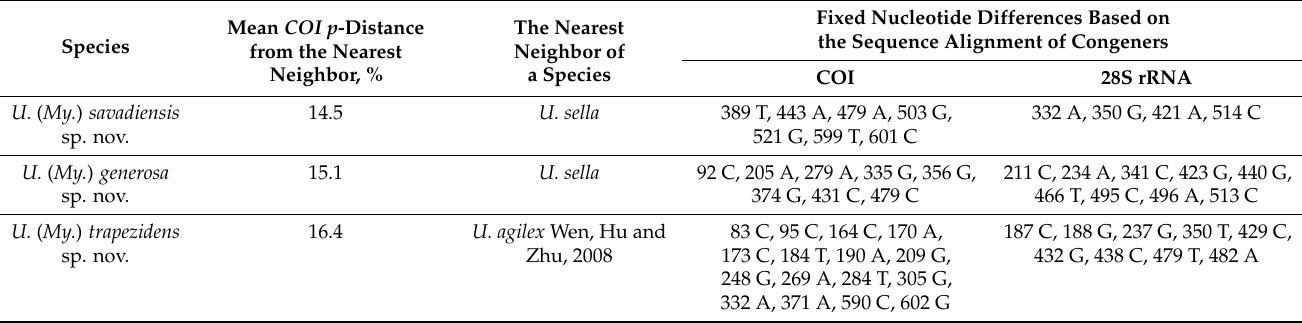
Table 2. Molecular diagnoses of new Unionicola ( Myanmaratax )